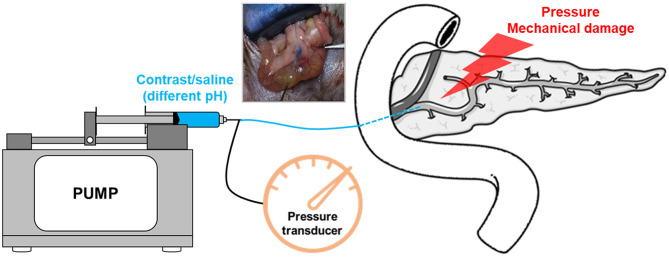
A schematic of experimental post-ERCP pancreatitis model. The model is induced by performing retrograde biliopancreatic ductal infusion, and the pump is used to control rate or pressure. Intraductal pressures can be monitored using a pressure transducer.